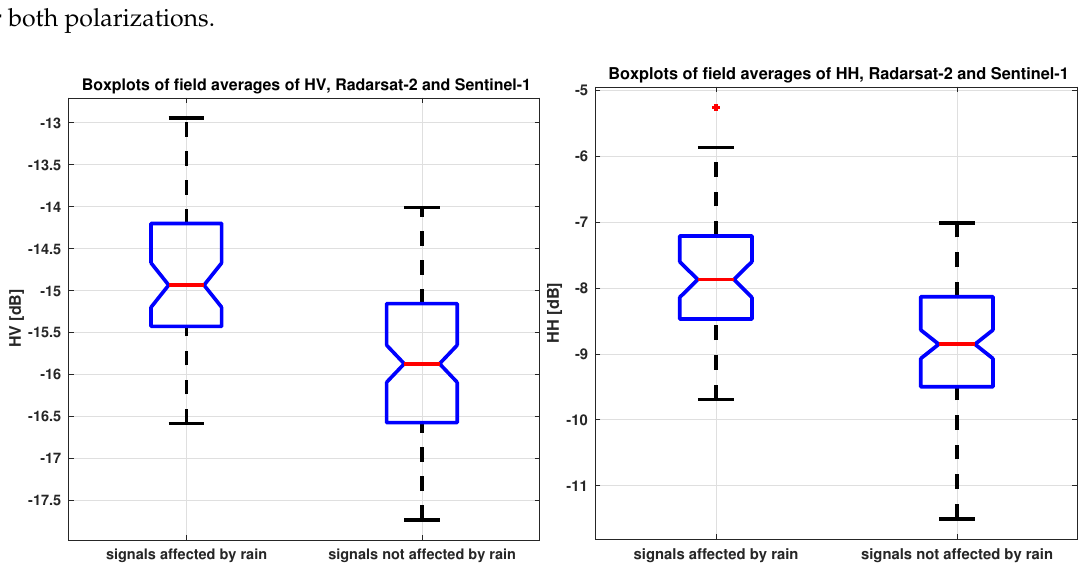
Figure 10. RS2 and S1 combined HV ( left ) and LS8 NDVI ( right ) signals versus binned values of estimated TCH, showing the effect of rain events on the signal. RS2 values were corrected for beam angles to the S1 angle. Additionally, the approximate and indicative axes of time from start of growth and stalk height are added. Bars illustrate standard deviations of remote sensing signals within each each TCH bin.